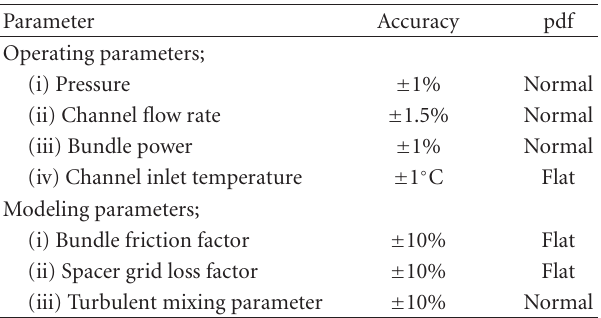
Table 4: Uncertainty parameters.